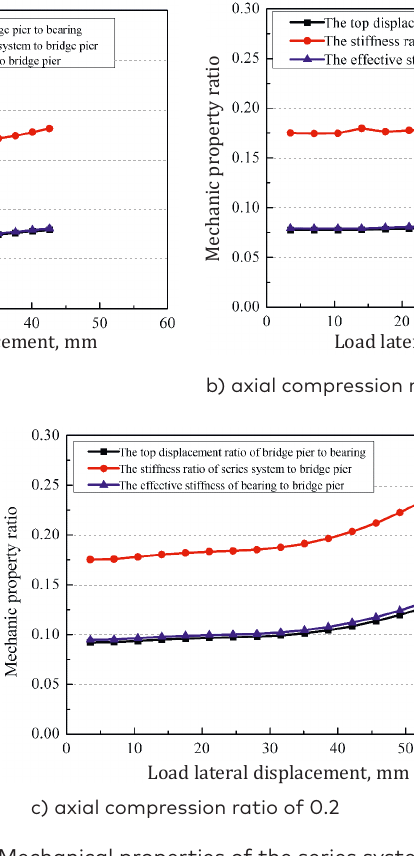
Figure 12. Mechanical properties of the series system with symmetry friction contact of friction coefficient of 0.1 at both ends of the bearing